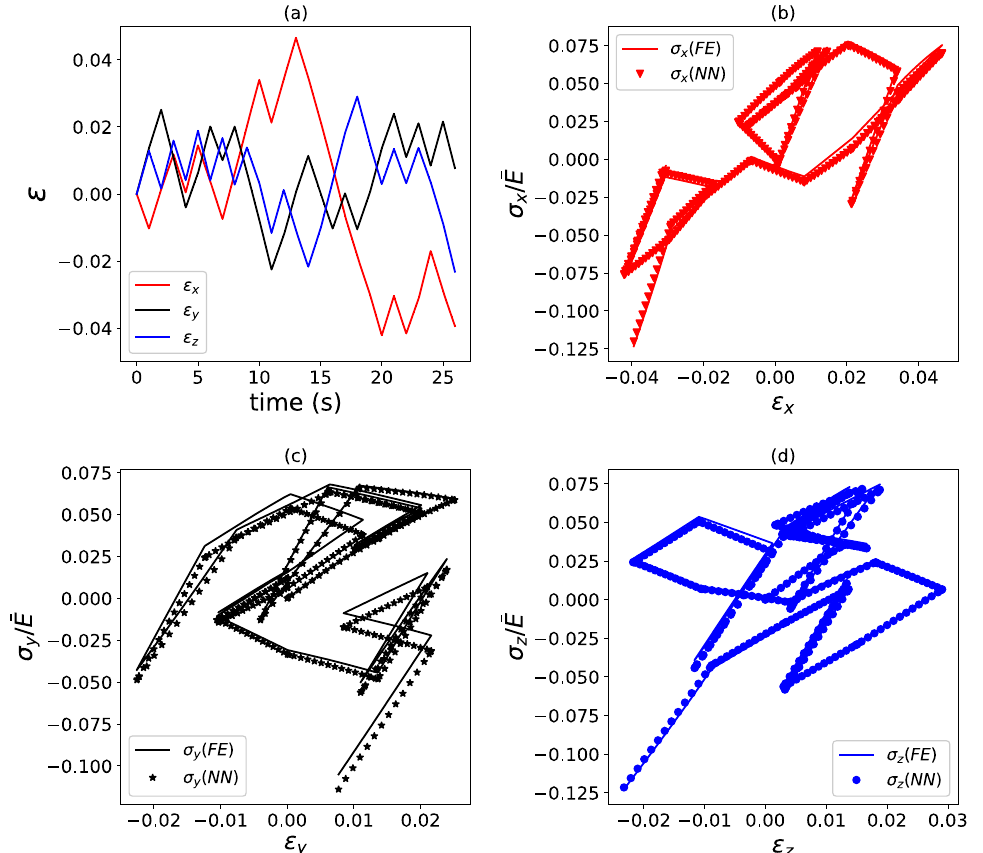
Figure 10. Example of strain versus time ( a ) and stress versus strain ( b – d ) histories for an elastic–plastic composite with κ = 2.0 . FE predictions are compared to predictions by a surrogate model. E σ = 17.8% for the load case shown, which used φ = 5000 training data